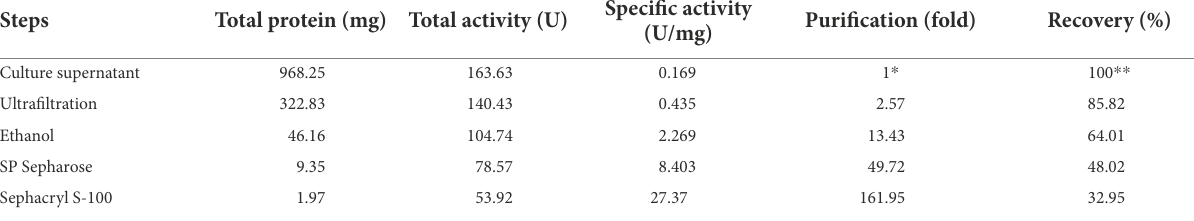
TABLE 1 Summary of purification of the PG from Chryseobacterium cucumeris ZYF120413-7. Steps Total protein (mg) Total activity (U)